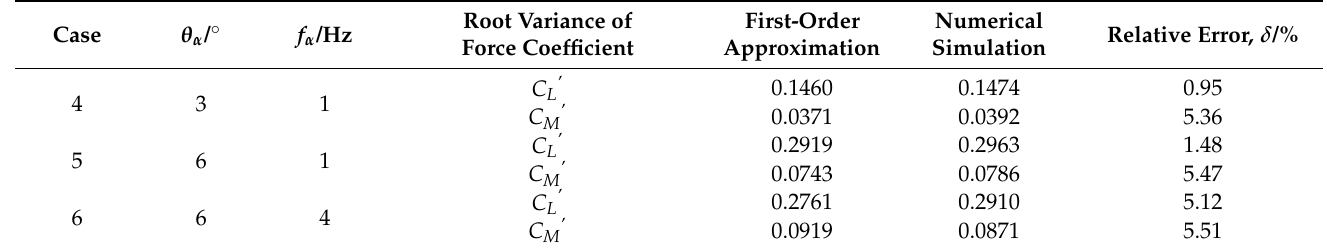
Table 2. Parameters of pitch motion and comparisons of